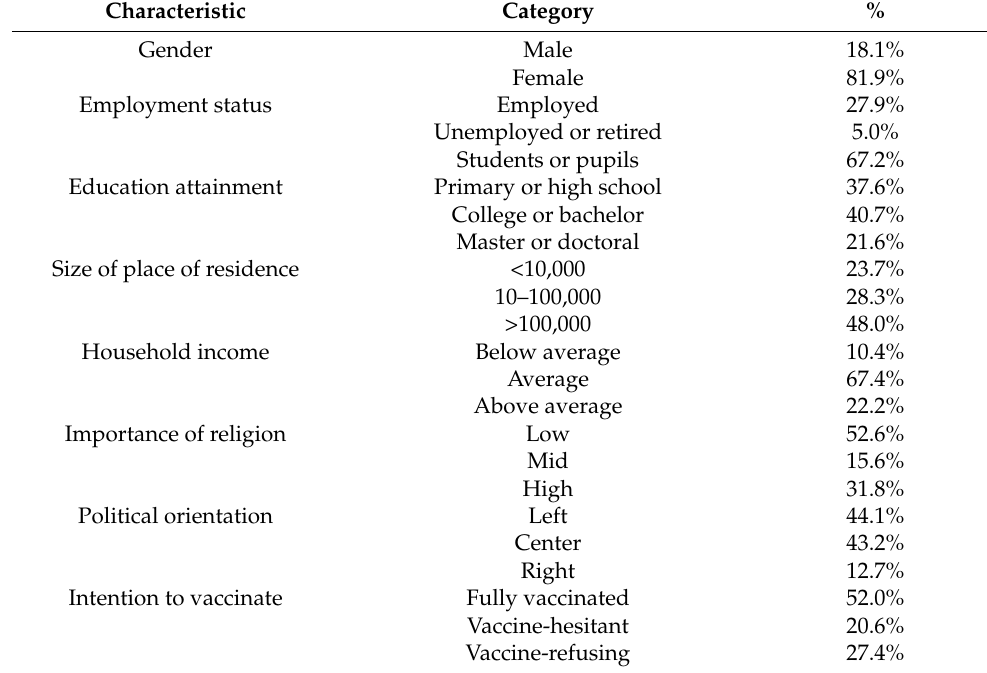
Table 1. Sociodemographic characteristics of the participants ( N = 481).